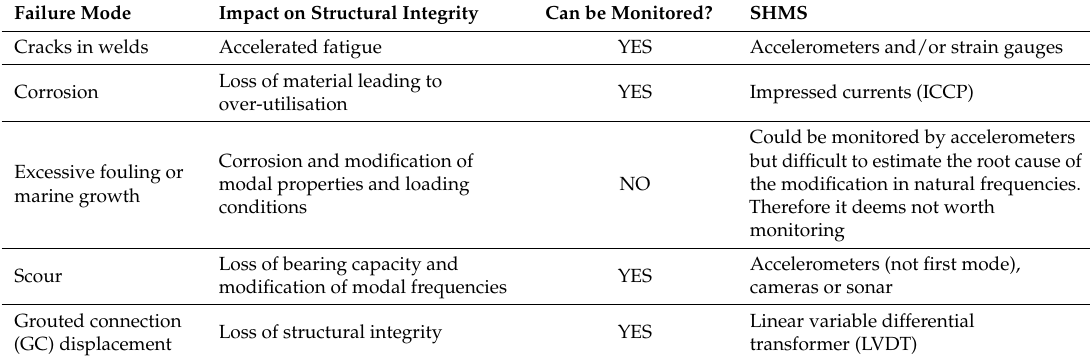
Table 5. Failure modes of wind turbine support structures and their effects on structure